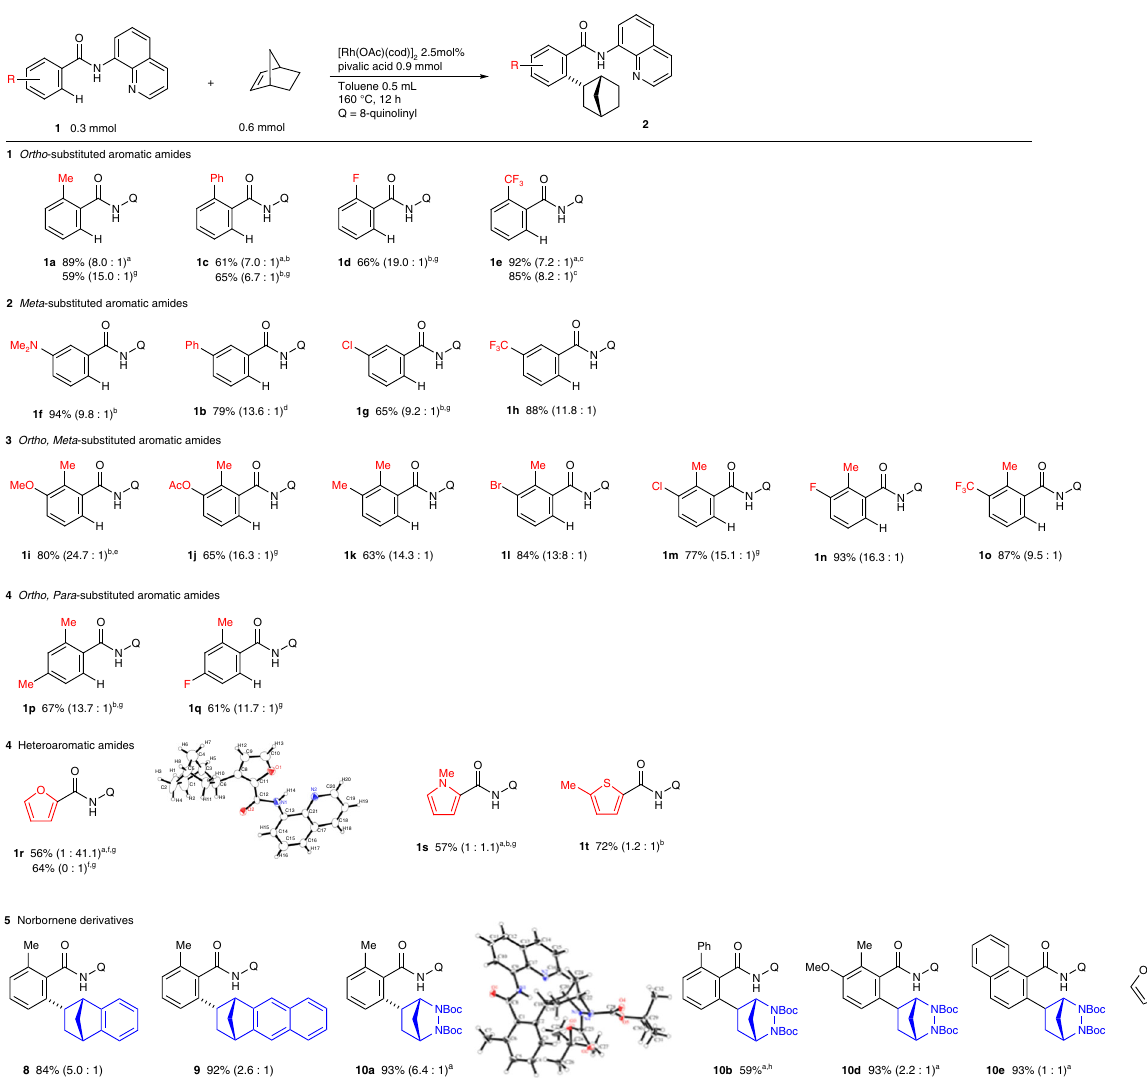
Fig. 4 Substrate and alkene scope. a The reaction was carried out in the absence of pivalic acid. b The reaction was carried out for 24 h with catalyst (5.0 mol%). c The reaction was carried out for 24 h. d 2,6-dimethylbenzoic acid was used in place of pivalic acid. e The reaction was carried out with pivalic acid (1 equiv) in toluene (1 mL). f The reaction was carried out at 120 °C. g Isolated by GPC. h The ratio could not be